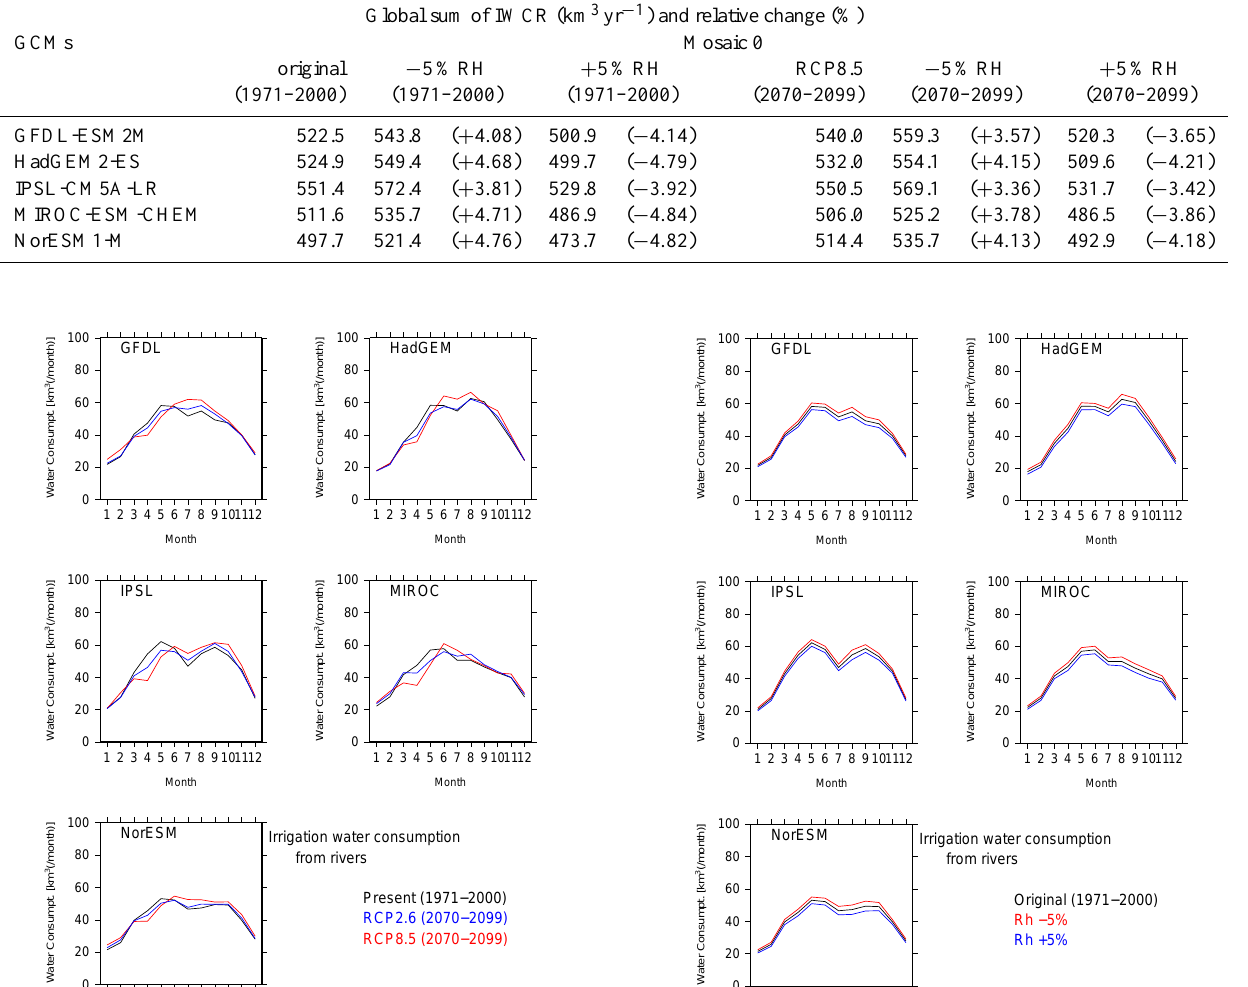
Table 5b. Results of the reference and sensitivity experiments with artificial biases of ± 5%RH – irrigation water consumption from rivers (IWCR). The values in parentheses are changes (%) relative to the original values.